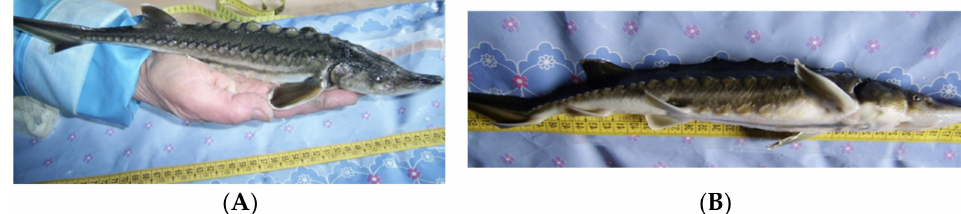
Figure 2. Sakhalin sturgeon Acipenser mikadoi , Okhotsky sturgeon part of salmon hatchery (Sakhalin island), 1+ age, ( A ) standard fingerling morphology, ( B ) tail downward curvatures and anal fin mechanical